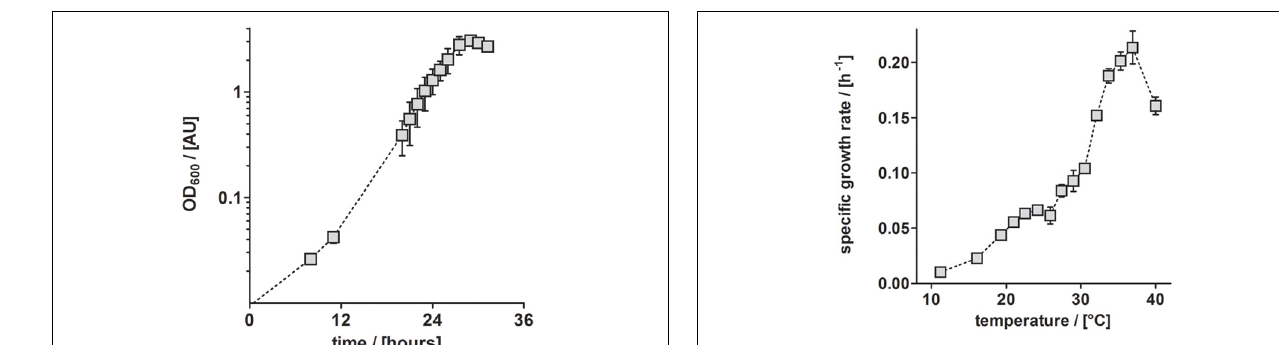
FIGURE 4 | Aerobic growth of P. denitrificans Pd1222 on the improved medium. Growth was performed with trace element solution TE-3-Zn with concentrations as given in Table 2 (series 4). The graphs represent three replicates; error bars indicate standard deviation and may be smaller than the symbols.